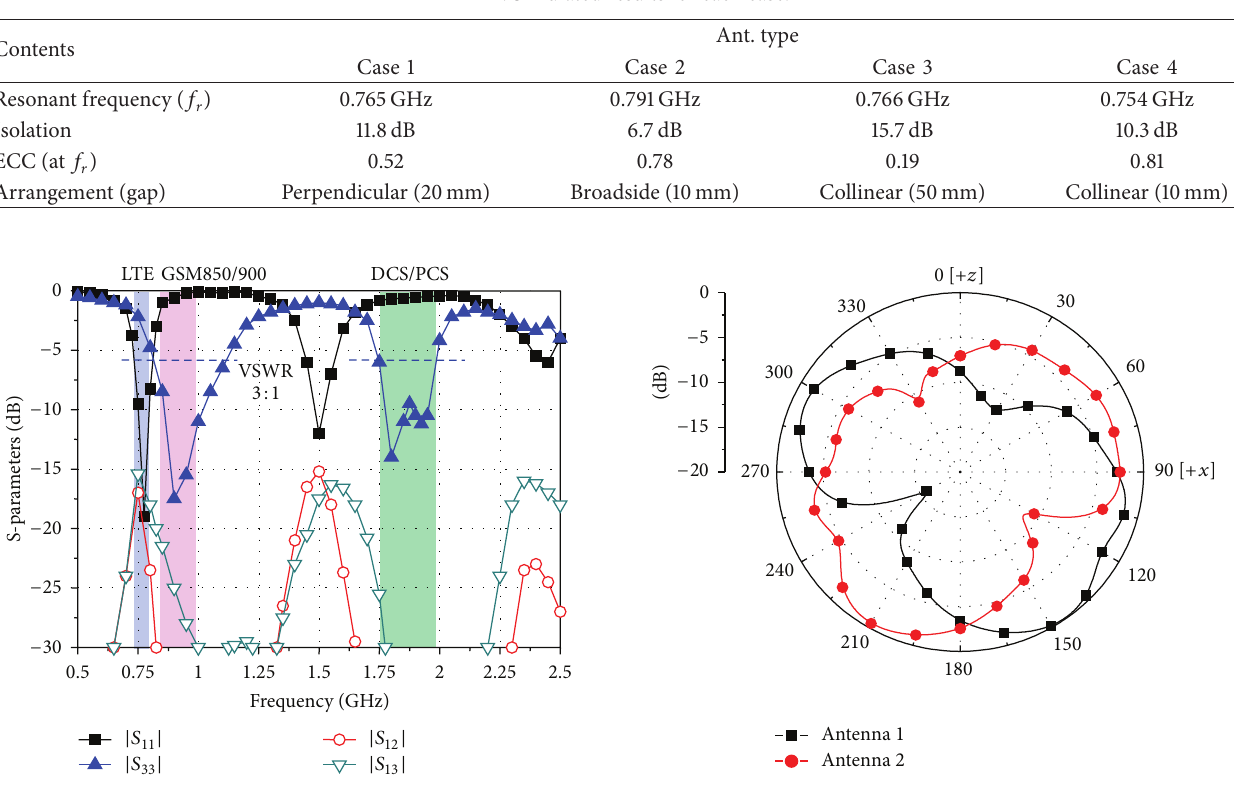
Figure 8: Measured radiation patterns at 766 MHz ( 𝑧𝑥